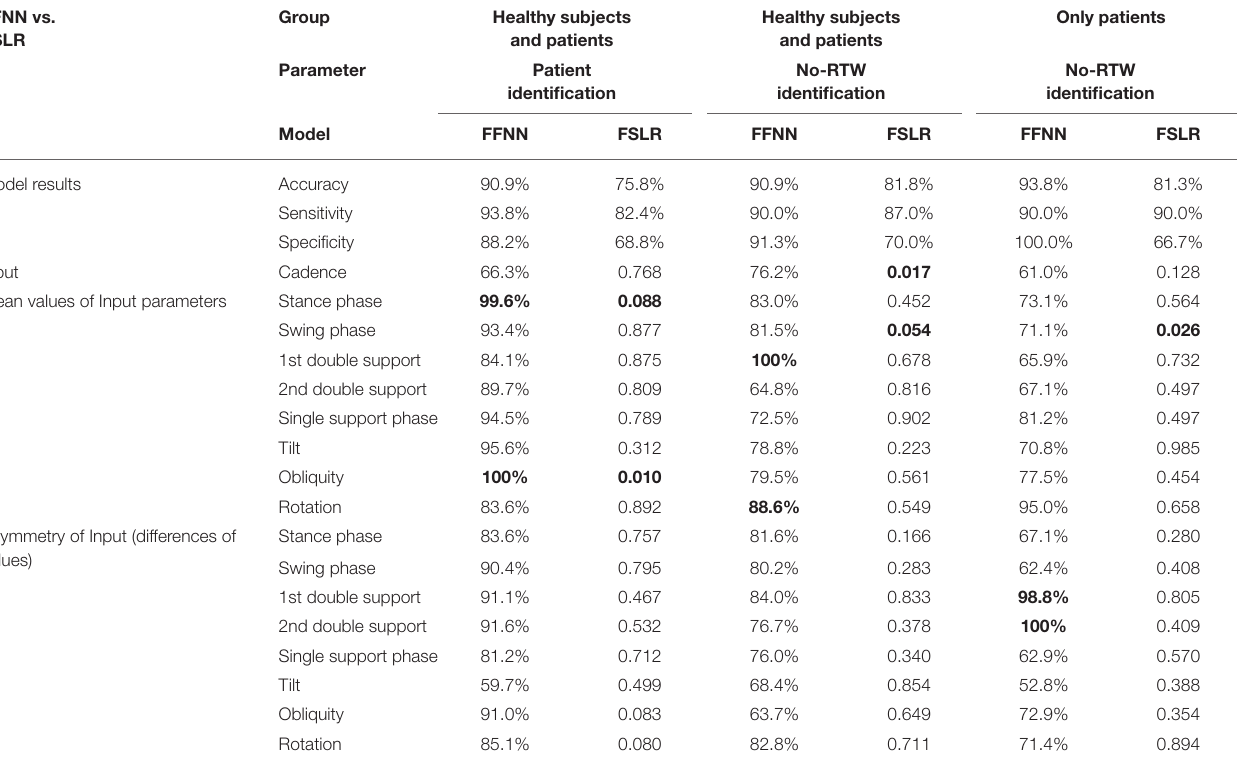
TABLE 2 | Comparisons of the performances (accuracy, sensitivity, and specificity) of feedforward neural network (FFNN) and forward stepwise logistic regression (FSLR) for identification of patients and patients unable to return to work (No-RTW). FFNN vs.